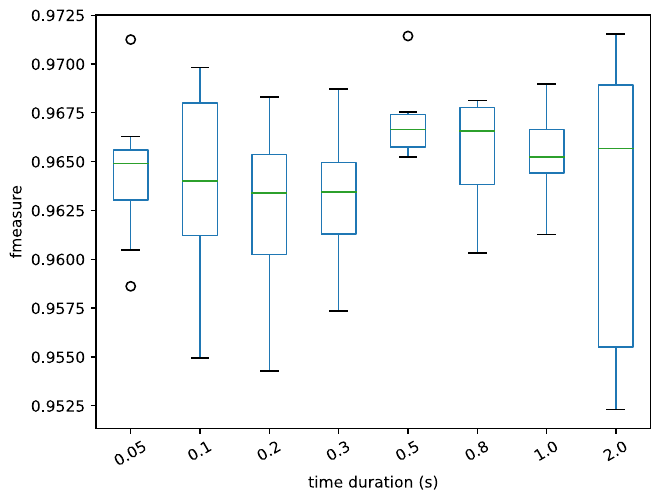
Figure 13. Performances of different frame sizes on the Jamendo dataset.